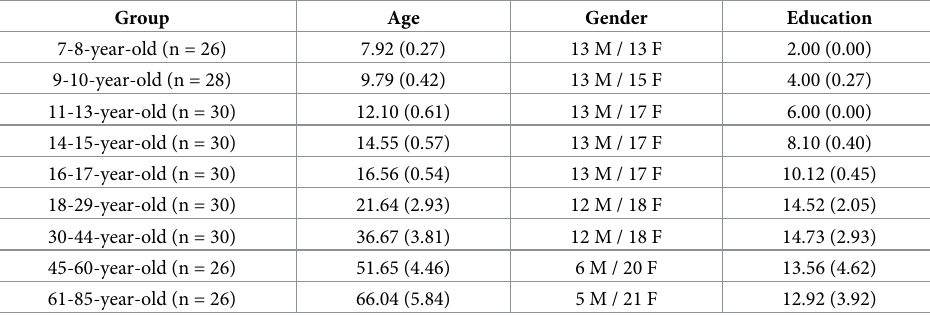
Table 1. Demographic data (means, standard deviations, and proportions) for all age